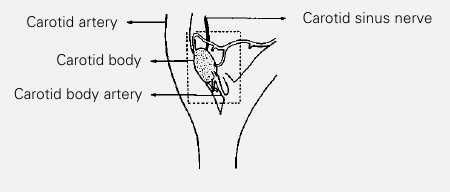
Figure 7 - Reflex arterial pres- sure and heart rate responses to intravenous injection of KCN (80 (cid:181)g/rat) one day after sham (CO), aortic (AD), carotid sinus (SD) and sinoaortic (SAD) den- ervation. Reproduced from Ref. 73, with permission.